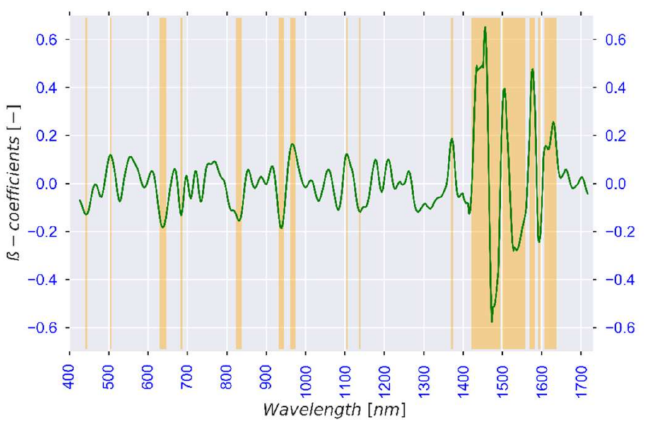
Figure 4. Features selected using PLS-BETA for moisture content (highlighted). The PLS-VIP method assigns VIP scores to each variable based on the weighted sum of squares of the PLS weights. The ‘greater than one’ rule is the standard utilised as the cut-off value to decide the features to be selected [64,128]. Figures 5–8 present PLS-VIP plots of the quality attributes under